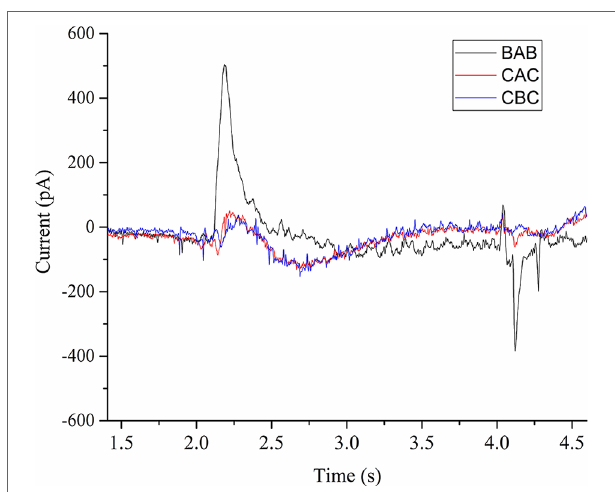
FIGURE 5 | Current transients induced by 100µM ATP concentration jumps in the presence of (BAB and CAC). The non-activating solution (B) in the case of BAB contained 1 mM MgCl2, 0.3 mM CaCl2, 20 mM MOPS, 150 mM choline chloride, 0.2 mM DTT, and pH 7.0. The non-activating solution (C) in the case of CAC contained 1 mM MgCl2, 100 µM ATP, 20 mM MOPS, 150 mM choline chloride, 0.2 mM DTT, and pH 7.0. The activating solution (A) contained 1 mM MgCl2, 0.3 mM CaCl2, 100 µM ATP, 20 mM MOPS, 150 mM choline chloride, 0.2mM DTT, and pH 7.0. In the case of CBC, activating solution was buffer B and deactivation solution contains buffer C.